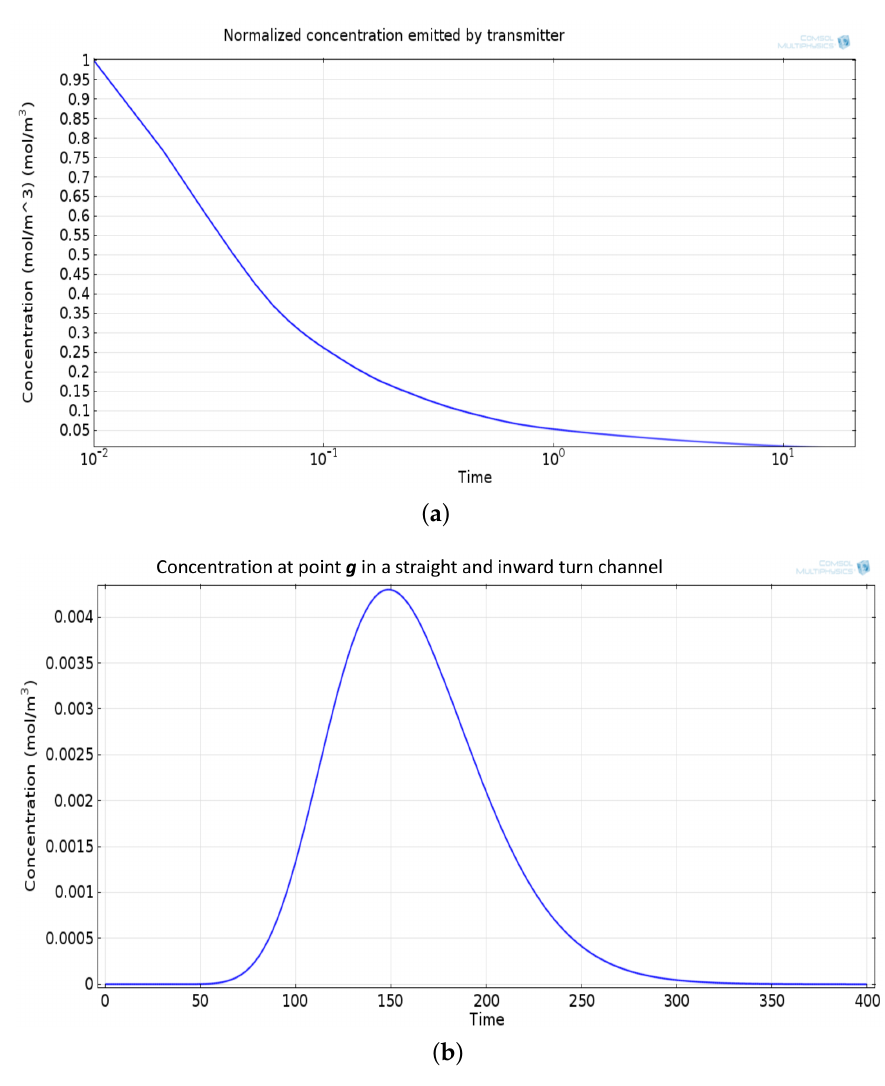
Figure 7. ( a ) Normalized concentration emitted by Tx. ( b ) Concentration signal at the point g , temporally spread and attenuated signal.